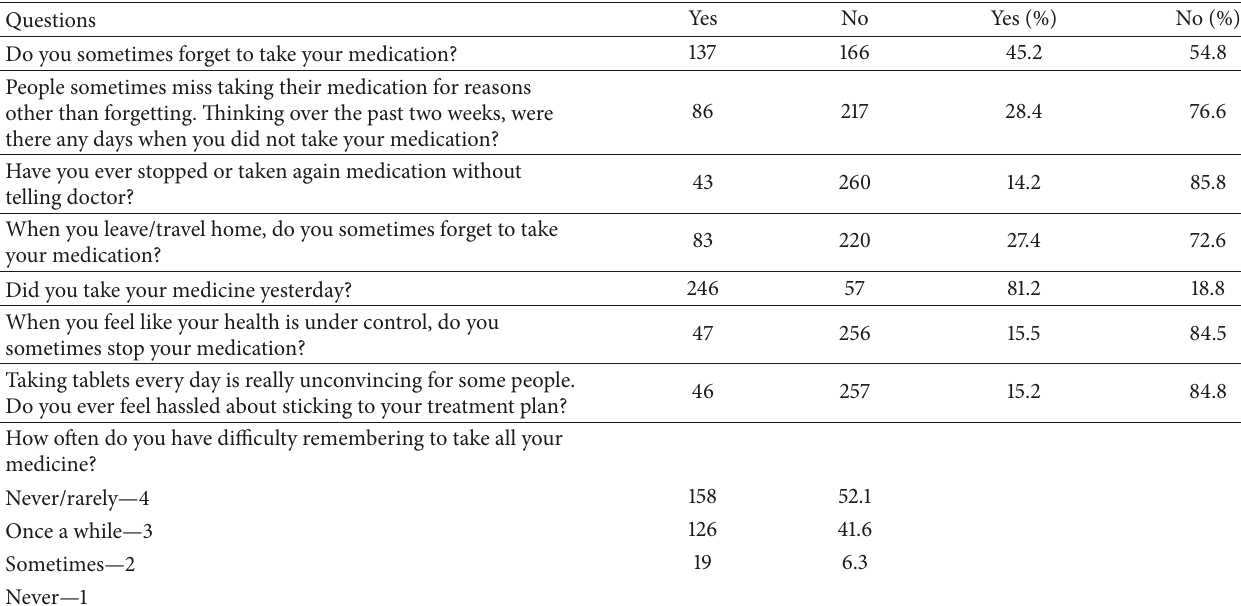
Table 4: Patient’s drug adherence of hypertension.